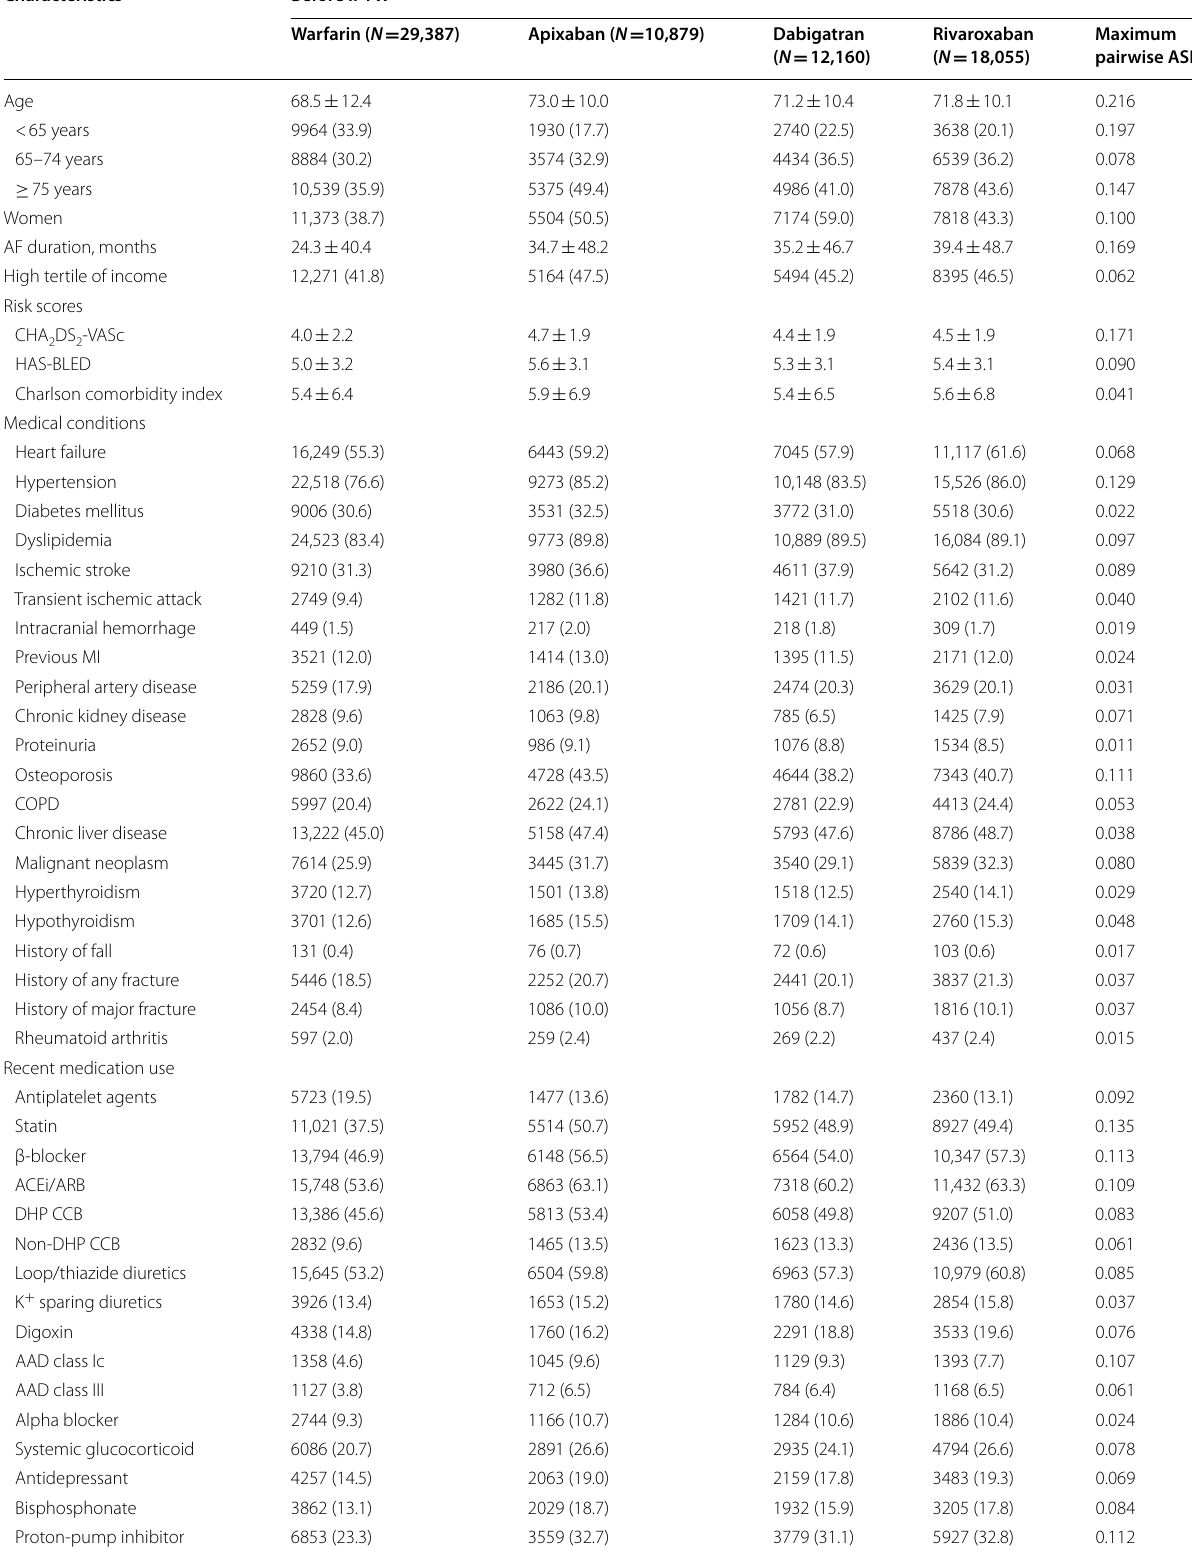
Table 1 Baseline characteristics before inverse probability of treatment weighting